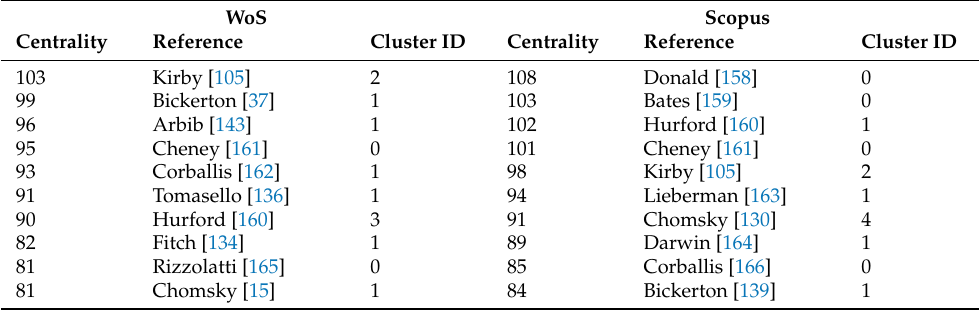
Table 7. Centrality of biolinguistics by references using scientometric indicators.